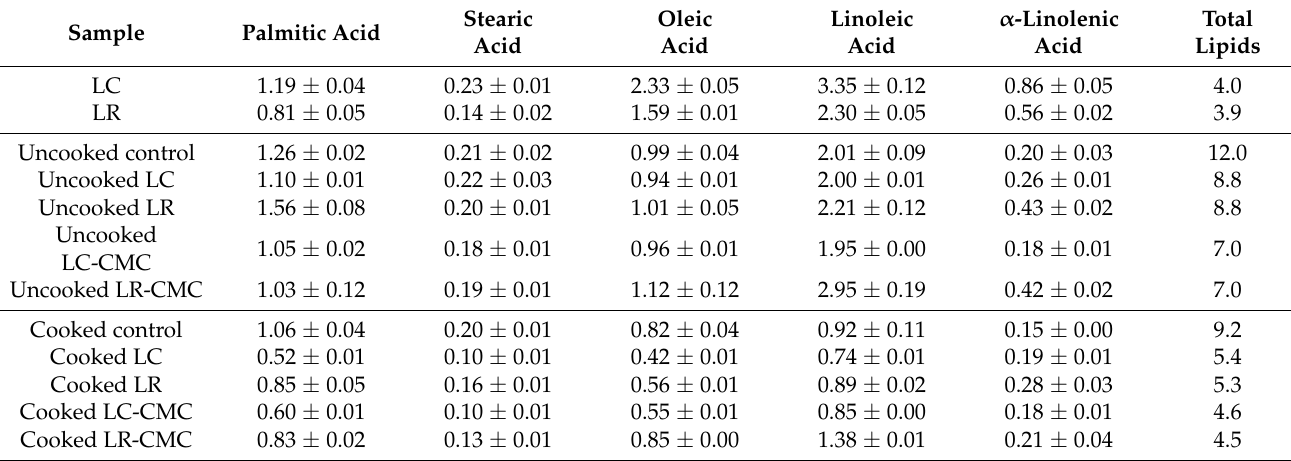
Table 2. Fatty acid content (mg g − 1 ± S.D.) in lentil accessions and in uncooked and cooked spaghetti: Lentil commercial cv. Easton (LC) and Lentil Ragusa (LR).